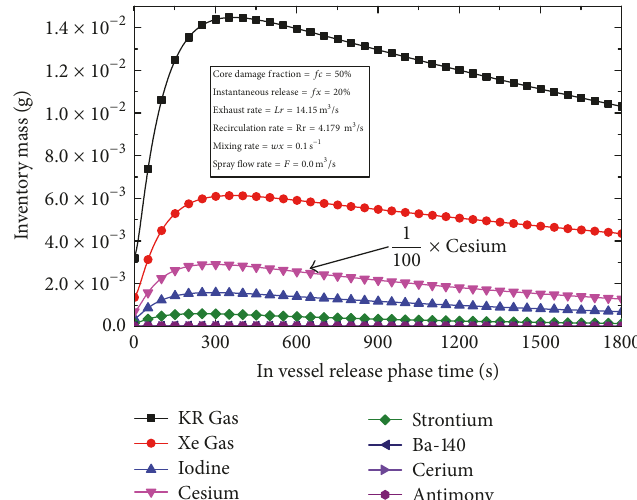
Figure 8: Radionuclide mass inventory during in-vessel release phase with mixing rate 𝑤 푥 = 0.1 s −1 .